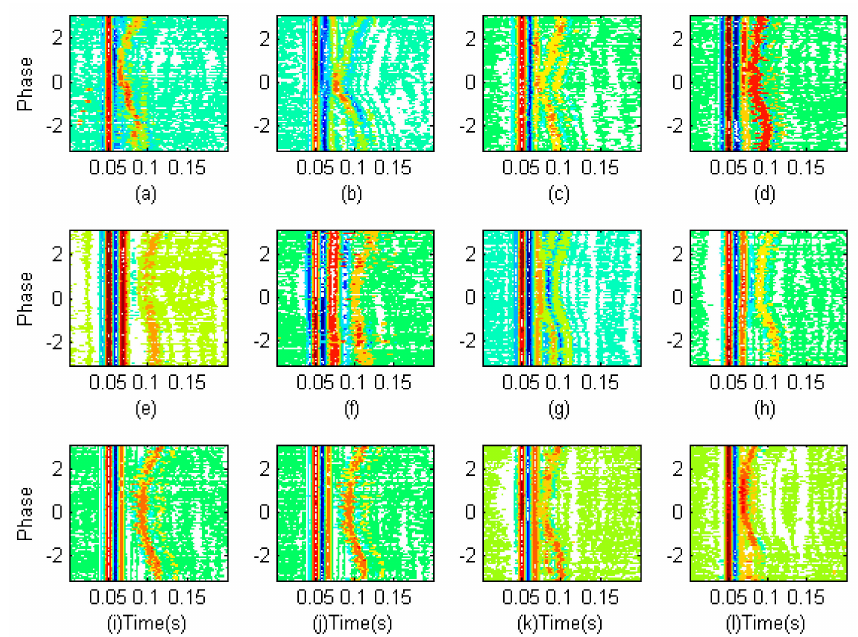
Figure 6. The second heart sounds from twelve subjects are demonstrated in joint time and respiratory phase domain. ( a – l ) subjects from No. 1 to No.